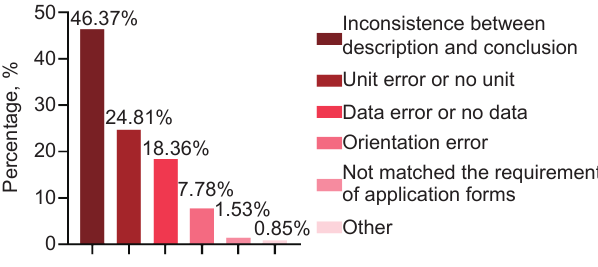
Figure 3 The common errors in report scoring from 2014 to